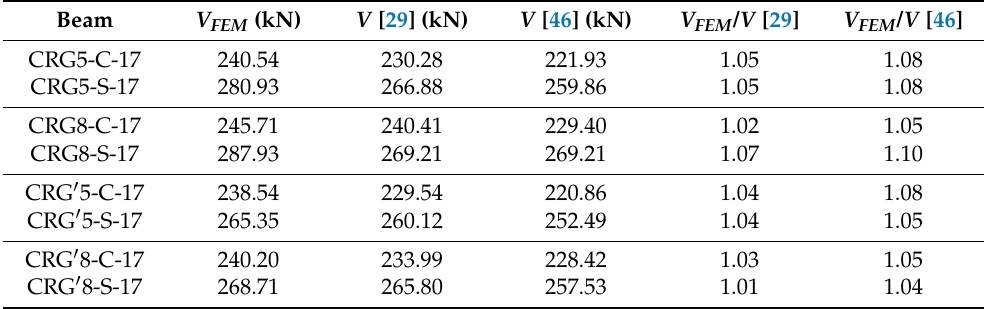
Table 10. Comparison of the shear capacity of beams obtained by the theoretical model and numerical